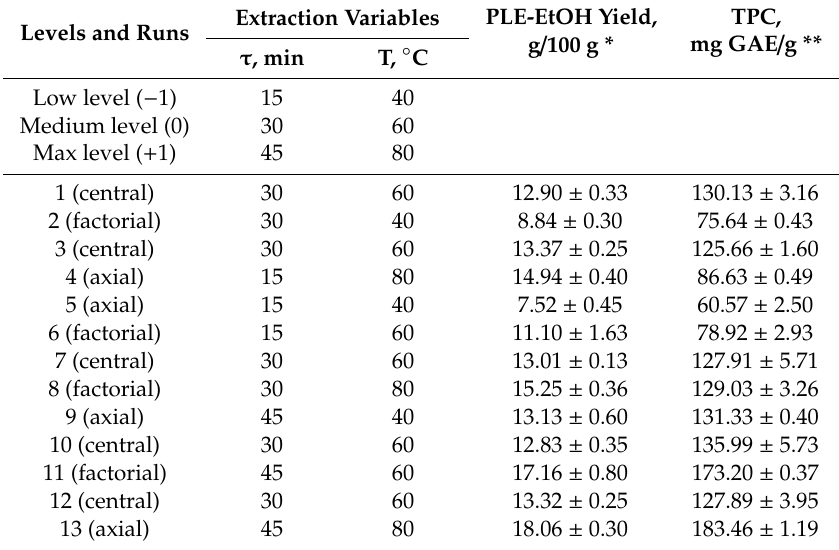
Table 3. Central composite design matrix for the pressurized liquid extraction with ethanol (PLE-EtOH) optimization of D. fruticosa leaves after PLE-Ac (10.3 MPa, 62 ◦ C, 45 min) and values of observed response factors RF I (PLE-EtOH extract yield, g / 100 g of residue after PLE-Ac) and RF II (TPC, mg GAE / g of pomace residue after PLE-Ac). TPC, Extraction Variables PLE-EtOH Yield, Levels and Runs mg GAE / g ** g / 100 g * τ ,